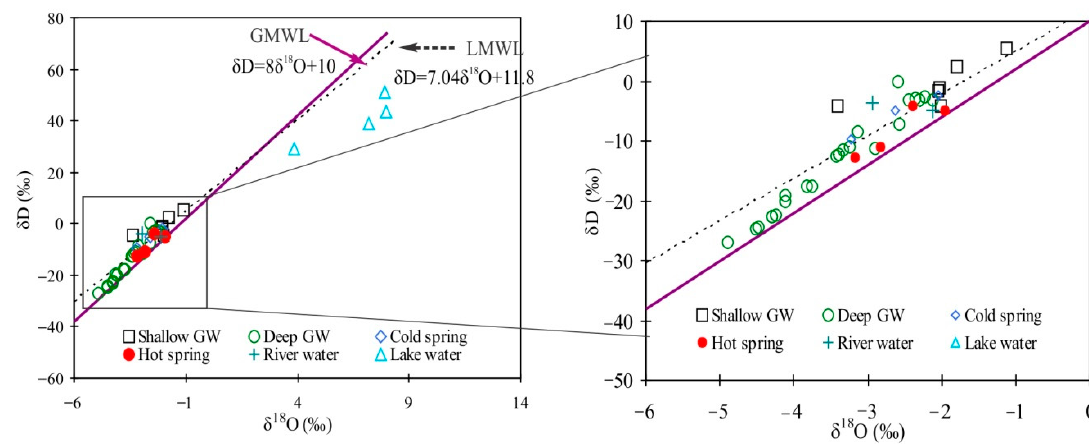
Figure 5. Relationship between δ 18 O and δ D values of Bilate water types compared with the Global Meteoric Water Line (GMWL), Addis Ababa Local Meteoric Water Line (AAMWL).